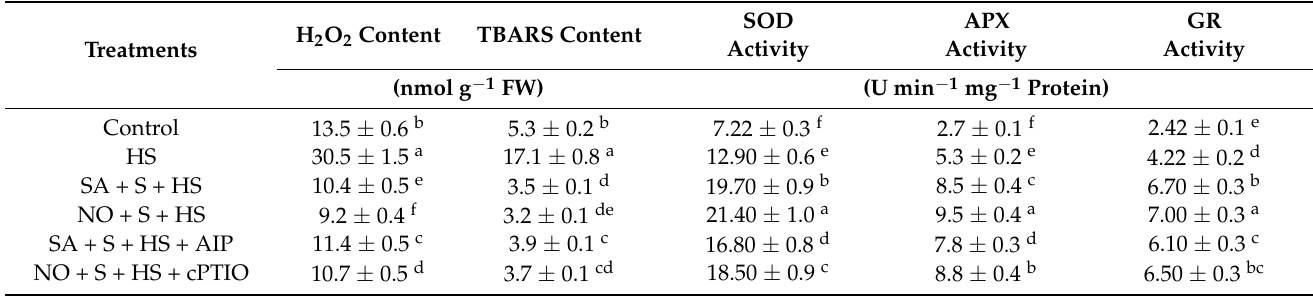
Table 4. Content of H 2 O 2 and TBARS (thiobarbituric acid reactive substance), and the activity of SOD (superoxide dismutase), APX (ascorbate peroxidase) and GR (glutathione reductase) of wheat ( Triticum aestivum L.) cv. HD-3226 treated with 0.5 mM salicylic acid (SA) or 50.0 µ M nitric oxide (NO) together with 2.0 mM SO 4 − 2 and/or 0.5 mM AIP and/or 100 µ M cPTIO in presence or absence of heat stress (HS; 40 ◦ C for 6 h daily for 15 days) at 30 days after